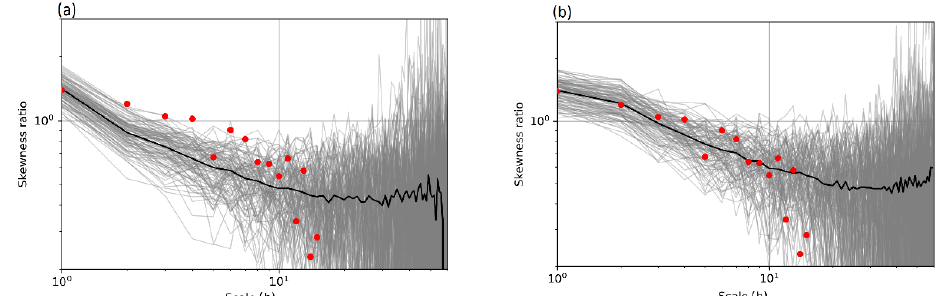
Figure 6. ( a ) 100 simulations with 10,000 length, preserving the irreversibility only at the first scale. ( b ) 100 simulations with 10,000 length, preserving the irreversibility at both the first and the second scales. The average of the simulations at each scale is shown in black, and each simulation is shown in grey. The red dots indicate the target theoretical irreversibility.